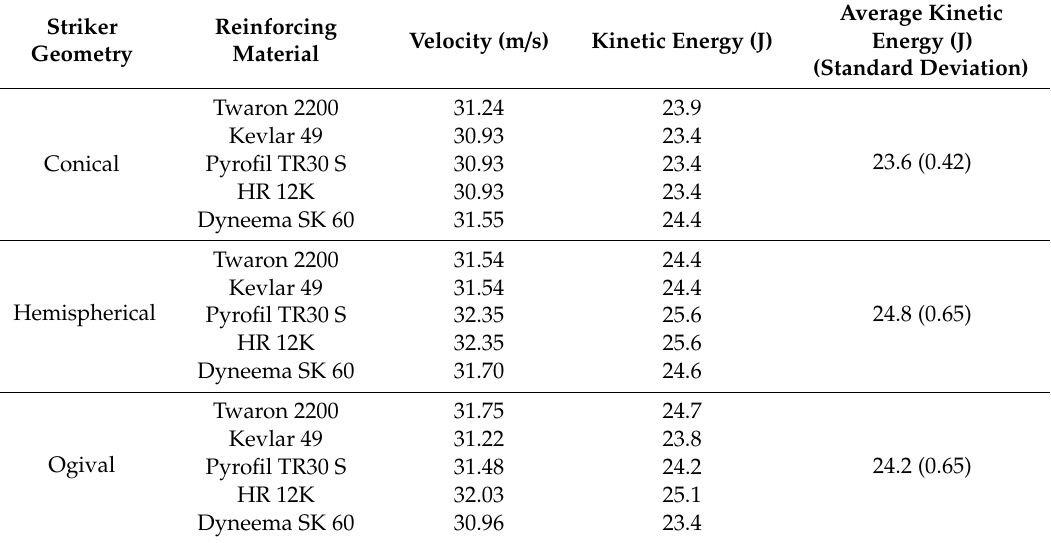
Table 4. Velocity and kinetic energy of the strikers before impact with the composite sample.